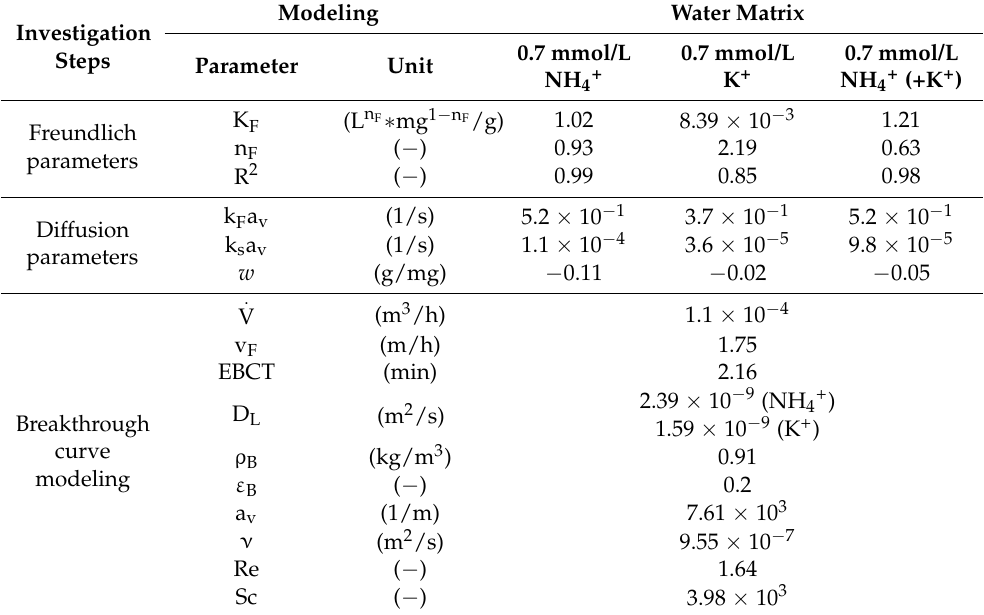
Table 1. Modeling parameters determined for each water matrix investigated x —Parameter abbrevia- tions can be found in the table footer xx